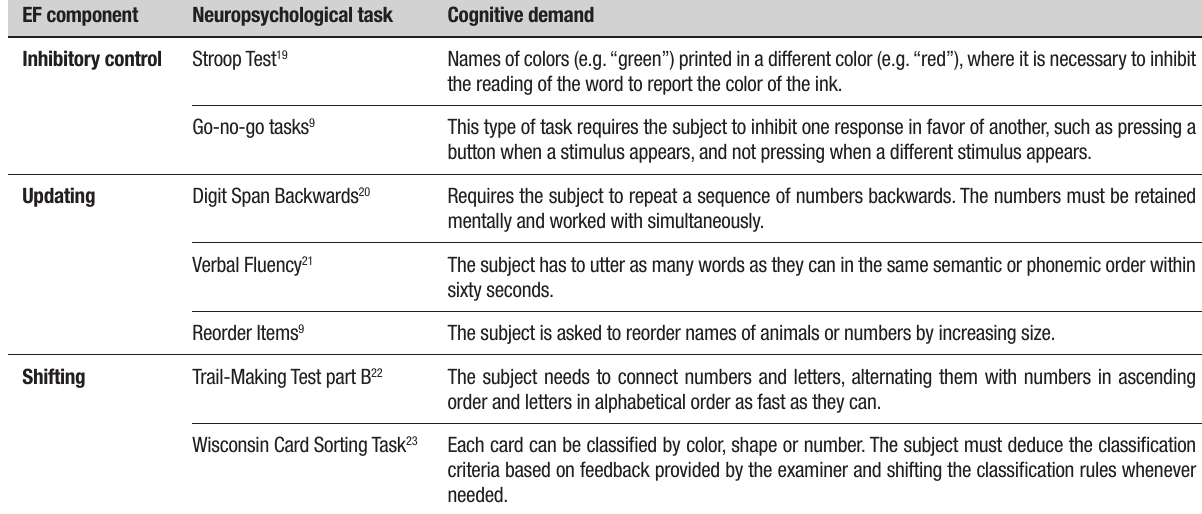
Table 1. Main neuropsychological tests that evaluate inhibitory control, updating and shifting components of EF. EF